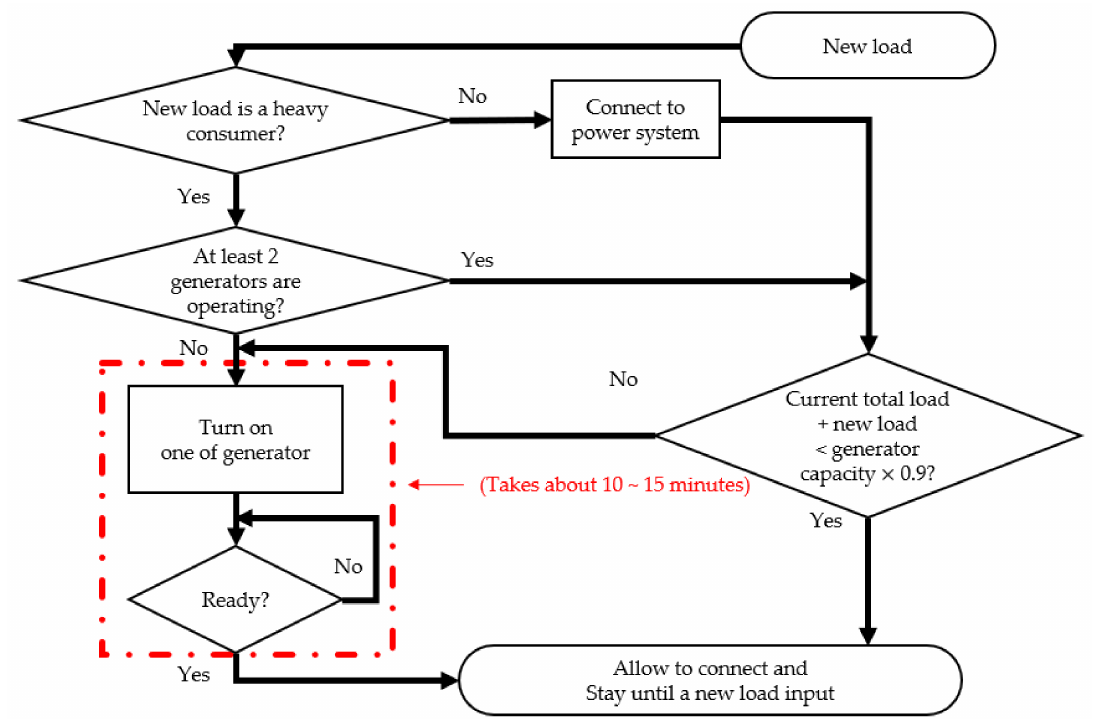
Figure 5. Typical power management system of an LNG